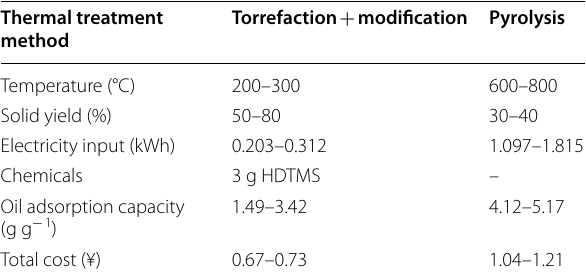
Table 5 Techno‑economic analysis of pyrolysis process and torrefaction plus modification process for oil adsorption (10 g raw